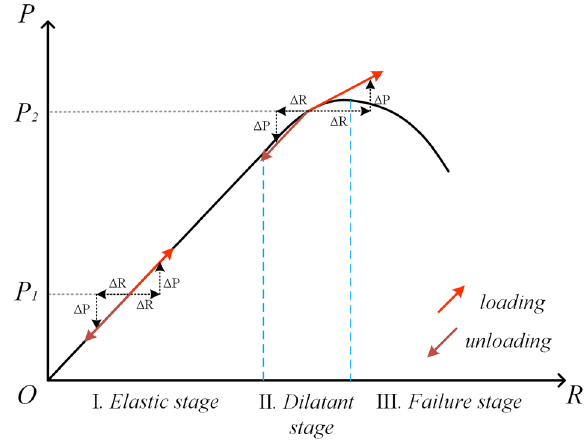
Figure 1. Schematic diagram of the rock constitutive relationship. P and R represent, respectively, the load and response. At the point P 1 in stage I, the response (ΔR) to the small changes of ΔP in the loading and unloading are almost the same. At the stage II (e.g. point P 2 ), the response to loading is significantly greater than unloading, and the stage III is characterized with macroscopic